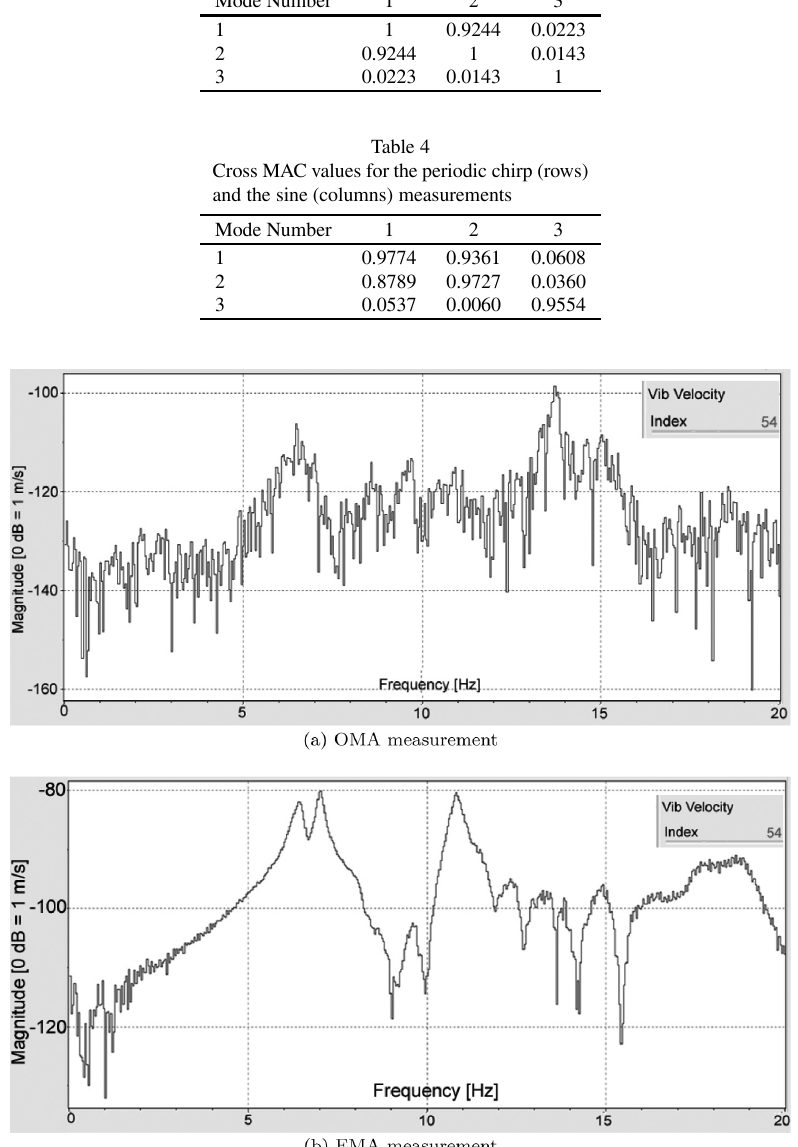
Fig. 10. Comparison of the vibrometer signal measured during OMA (top) and EMA (bottom), in measurement point